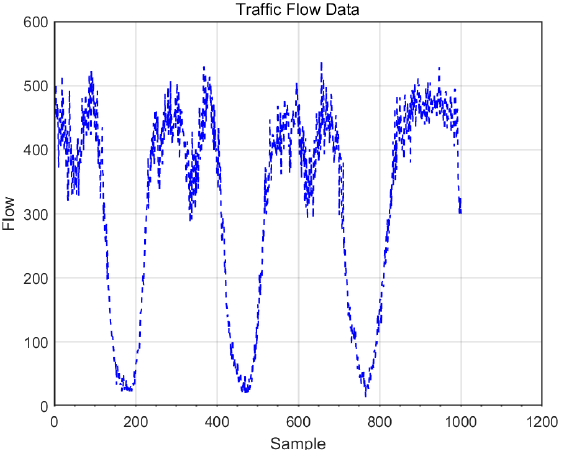
Figure 5. Traffic flow map.